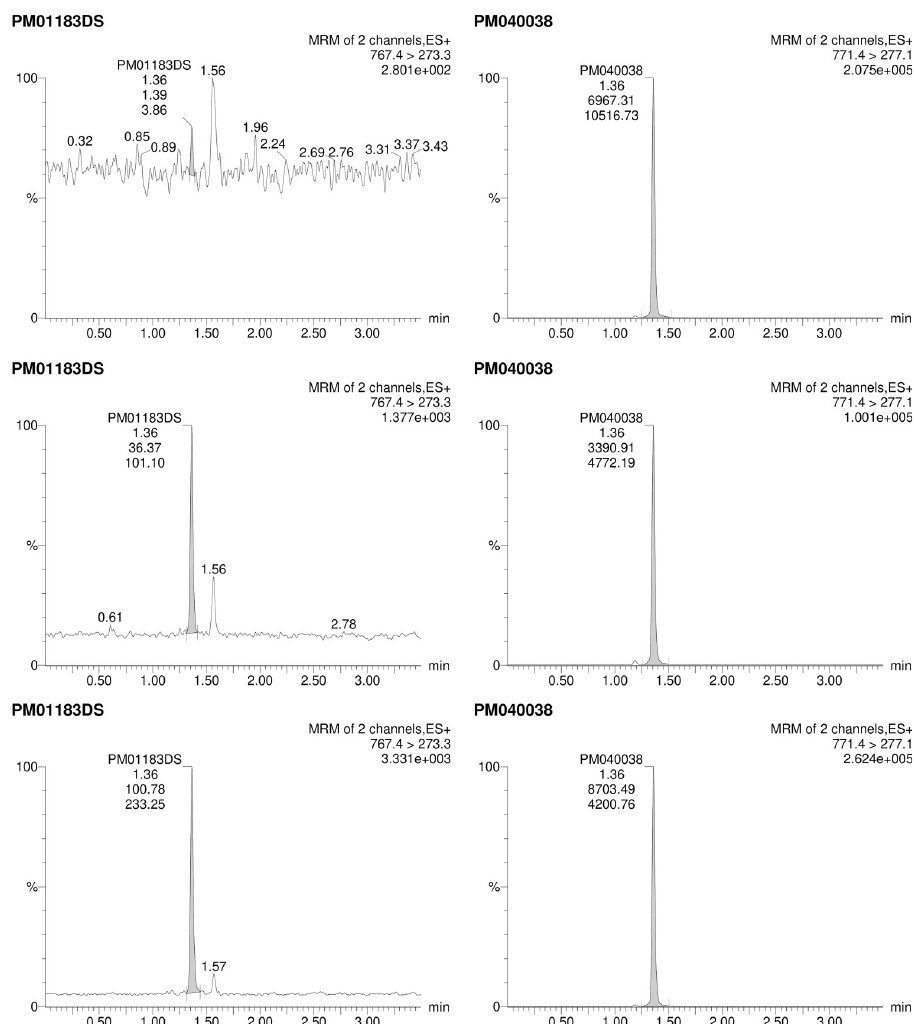
Fig 3. Chromatogram of Lurbinectedin Blank (upper), LLOQ (middle), and a Treated Patient Plasma:PBS Samples, With Internal Standard (right). LLOQ, lower limit of quantitation; MRM, multiple reaction monitoring; PBS, phosphate-buffered